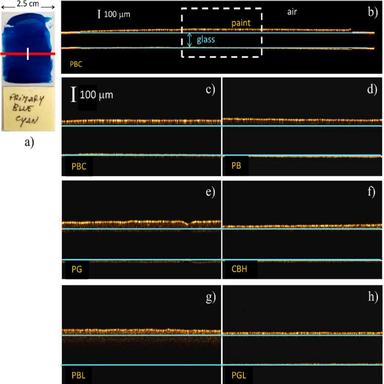
a) Bright field image of the Primary Blue Cyan sample showing the position of the two OCT profiles acquired on each sample: red line (25 mm scanning length and 1 mm deep) and white line (5 mm scanning length and 1 mm deep), orthogonally oriented and crossing at the centre of the painted surface; b) OCT tomogram of PBC paint acquired along the red line (25 × 1 mm; scale bar = 100 μm in-depth) displaying the paint layer (coloured in yellow) over the glass support (light-blue lines); the central area, consider